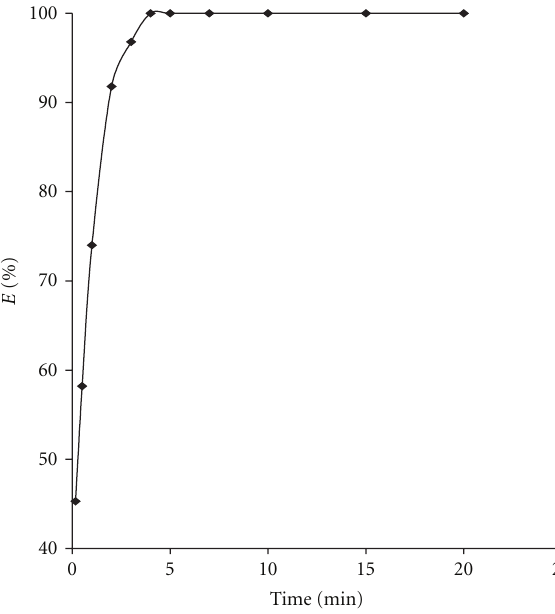
Figure 2: E ff ect of equilibration time on the extraction of neodym- ium(III) from 0.06 M sodium succinate at pH 6.0; 0.1 M N- n - octylaniline in xylene.